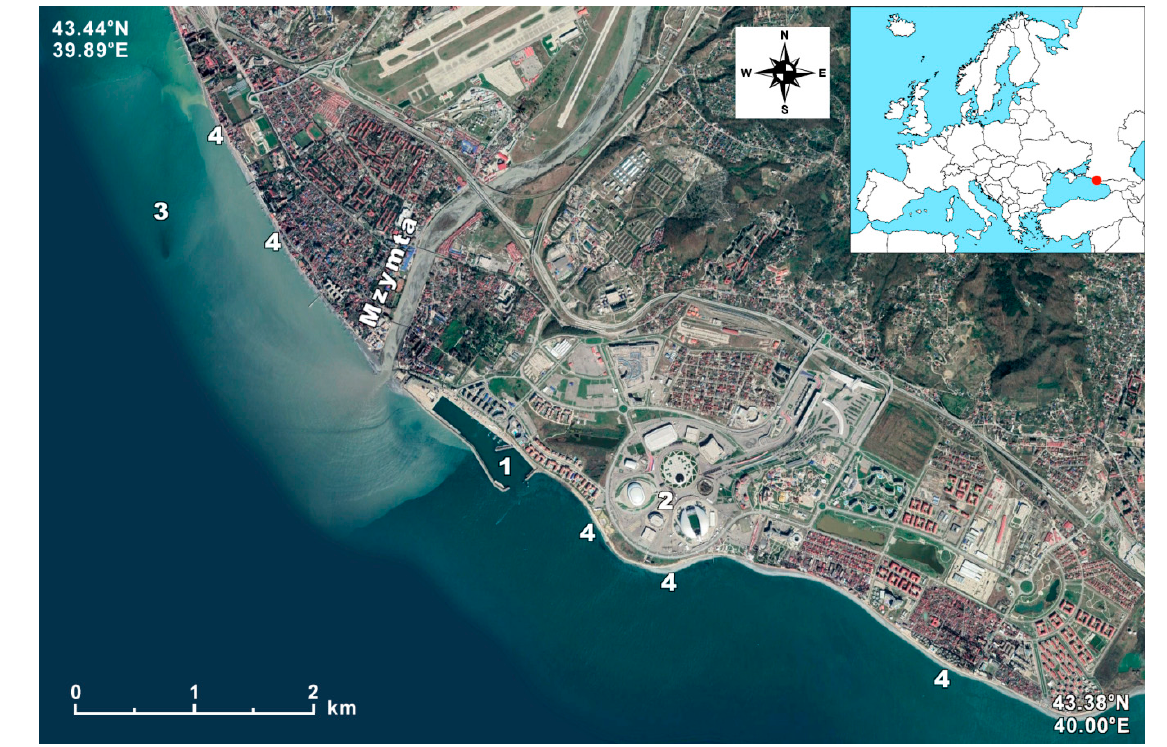
Figure 1. Study area in the northeastern part of the Black Sea. 1 Imereti port; 2 Olympic Park; 3 wastewater outfall; 4 beaches.